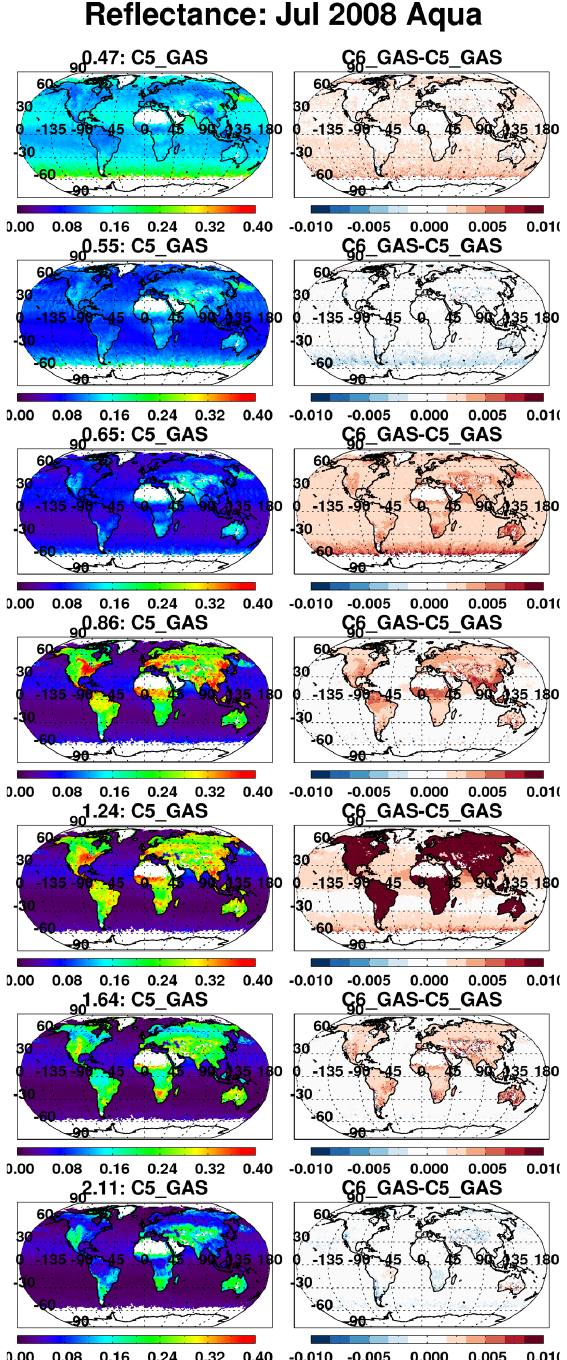
Fig. 5. Gridded “average” Level 2 reflectance from Aqua for July 2008, demonstrating impact of using new gas absorption cor- rections on the reflectance used to derive aerosol. For each wave- length band (each row), the left panel is produced from assumption of C5 gas absorption, and the right panel is the difference (C6–C5) when applying inputs of C6 gas